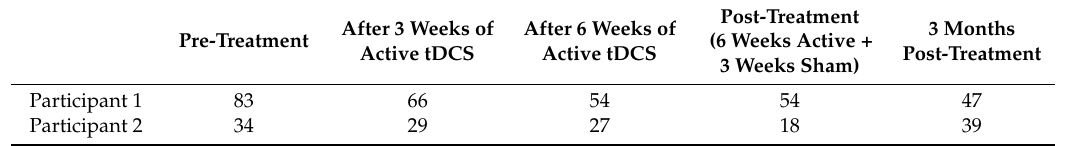
Table 1. Adult Tic Questionnaire (ATQ) scores.